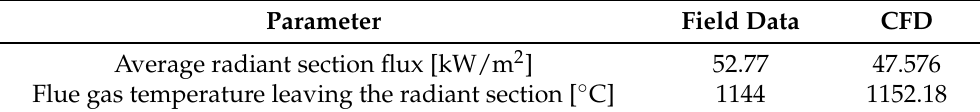
Table 11. Comparison between field datasheet and CFD results in the radiant section.